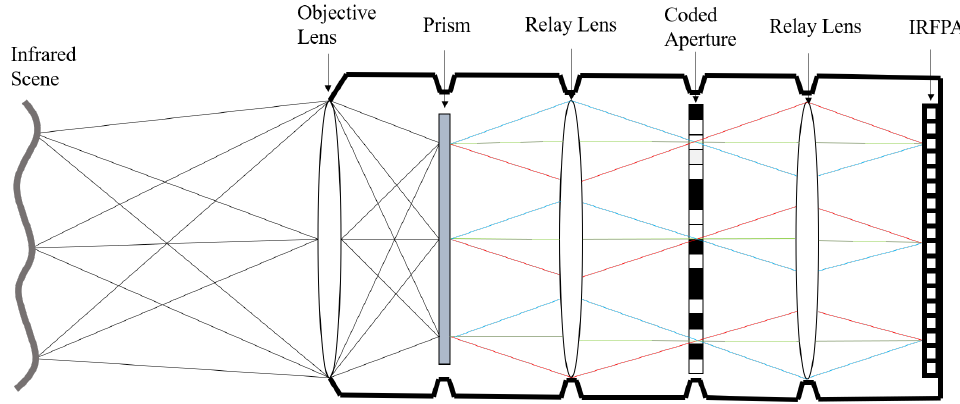
Figure 2. Illustration of the MWIR-SCSI sampling